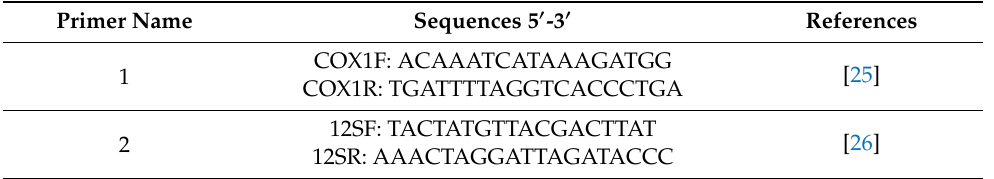
Table 1. Primers used in this